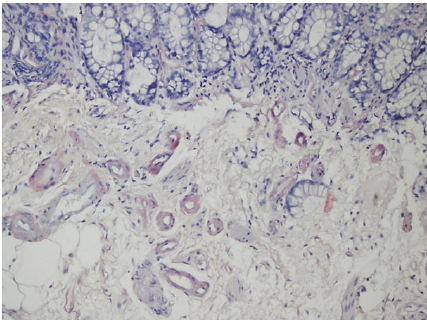
Figure 3: Amyloid is noted in the submucosal vessels (Congo red stain ×